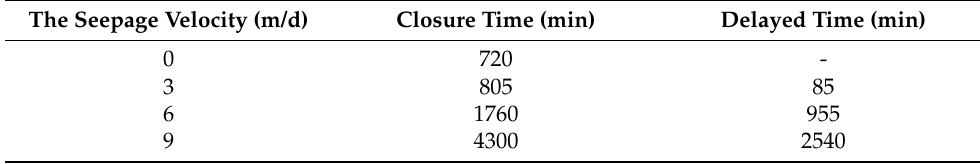
Table 5. The closure time of the frozen wall under different seepage velocity. The Seepage Velocity